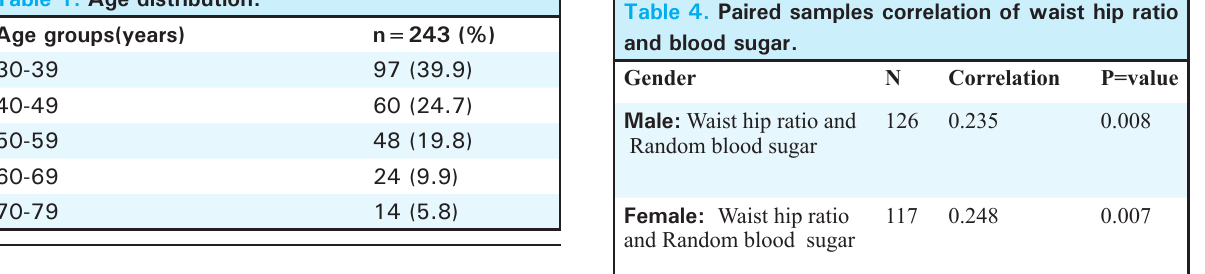
Table 1. Age distribution.